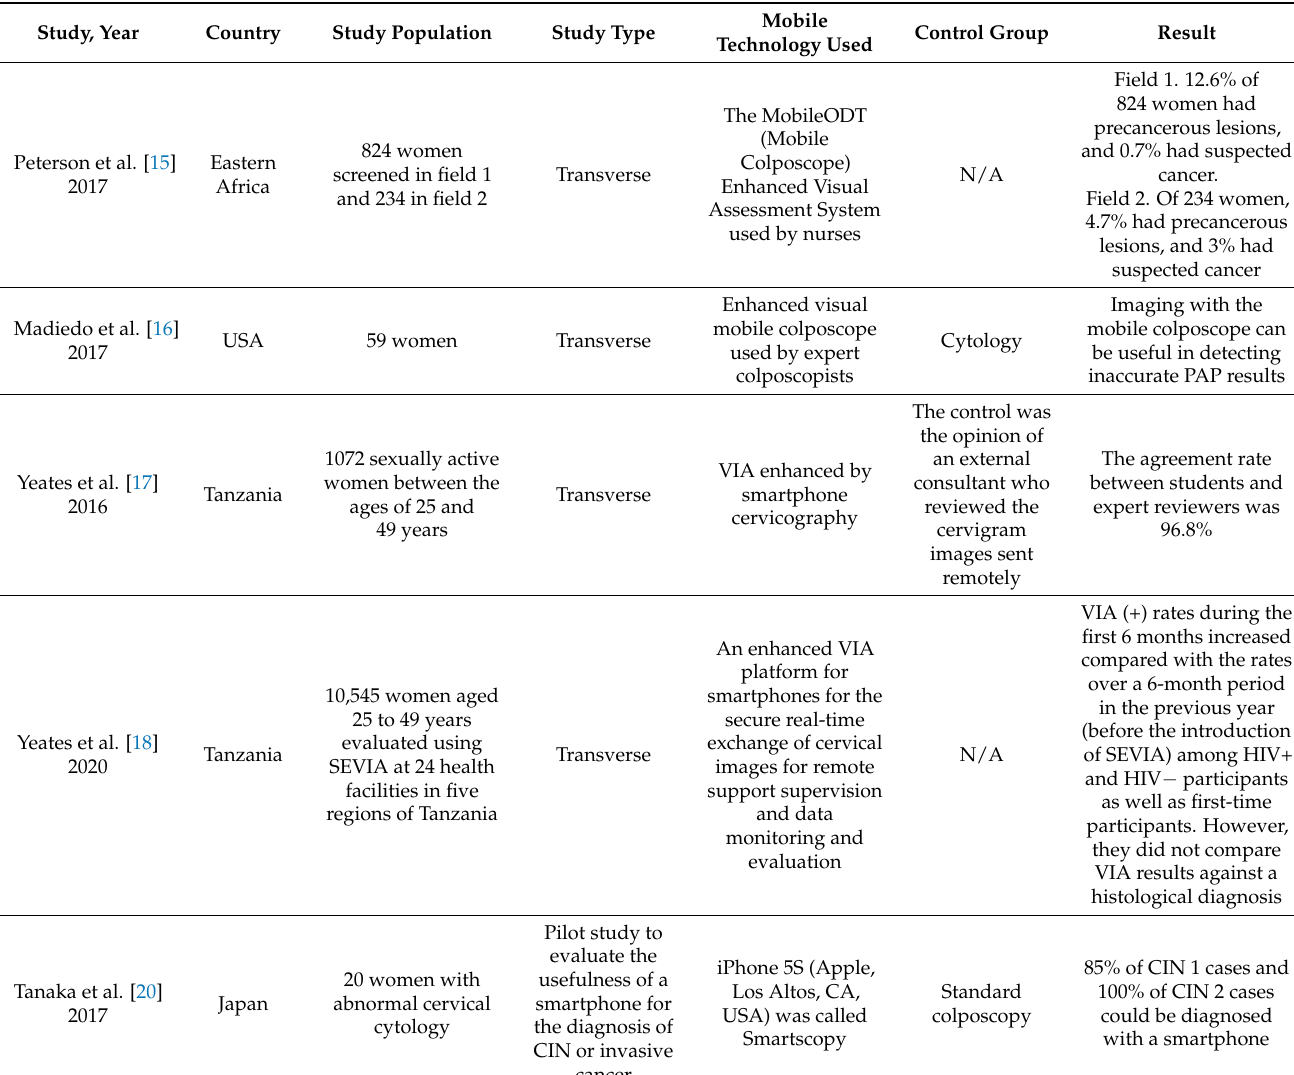
Table 3. Usefulness of a smartphone in detecting cervical